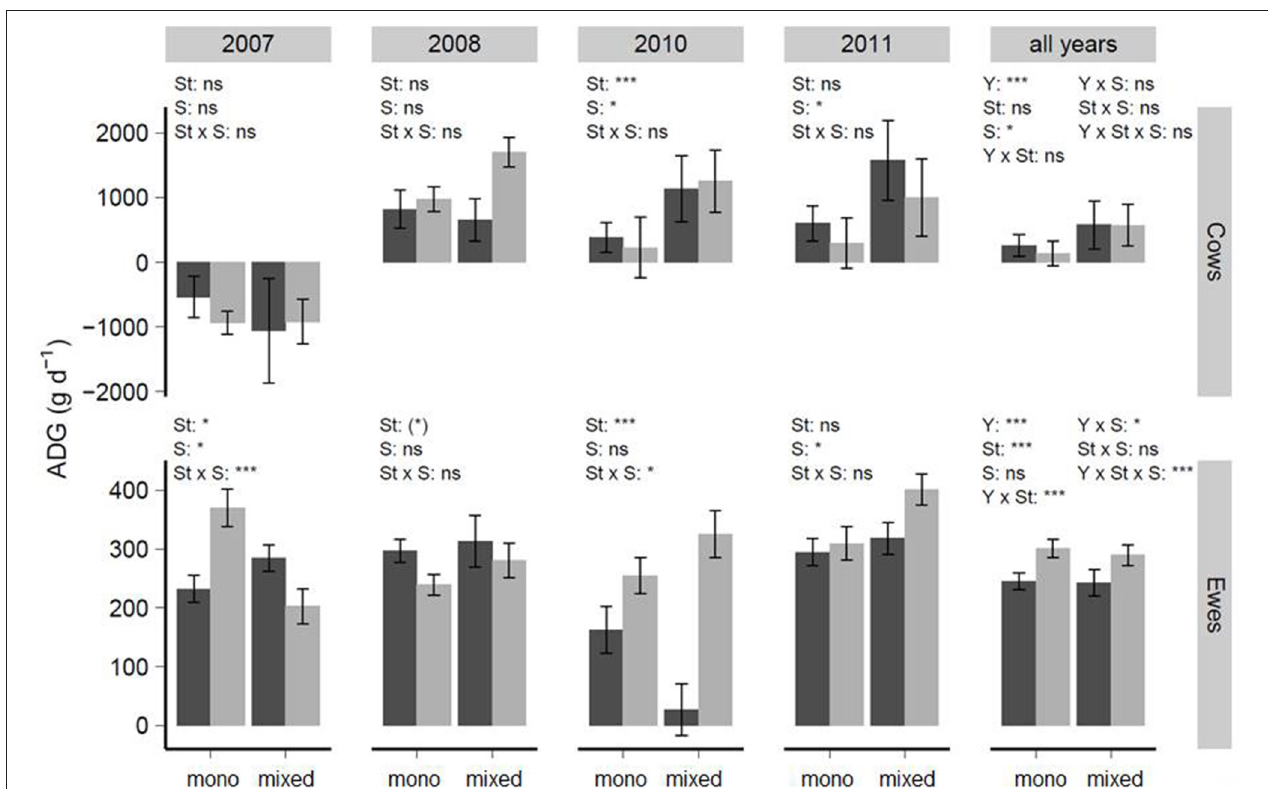
FIGURE 4 | Average daily animal-ADG (animal-ADG, g d − 1 ) of suckler cows and ewes (means ± se) in relation to year, sward type (St) and grazing system (S, mono- or mixed-grazing). The dark gray bars highlight grass-dominated swards, while light gray bars show diverse-swards. In statistical analyses of suckler cow animal-ADGs, the varIdent-structure was used to model heterogeneous variances between sward types (2007, 2010) or years (all years-model). Concerning ewes, the same variance modeling was used to account for differing variances between grazing cycle (2011) and years (all years-model). ns, not significant, P < 0.1, * P < 0.05, ** P < 0.01, *** P < 0.001.